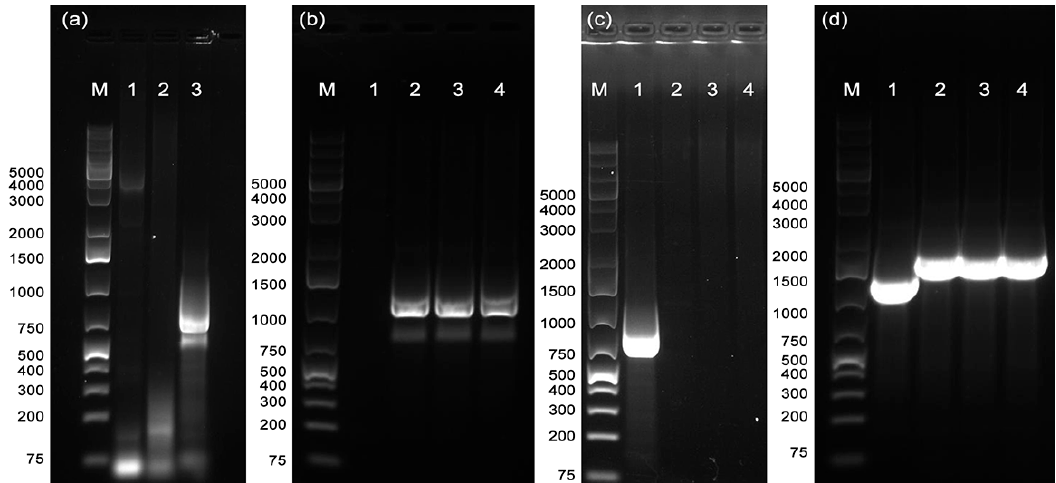
Figure 5. Fluorescence microscopy observations of X. fastidiosa strain De Donno transformed with the pKLN59 plasmid harboring the green fluorescent protein (GFP) gene. Cell aggregates were collected from buffered charcoal yeast extract (BCYE) agar plates supplemented with kanamycin, after five rounds of restreaking.